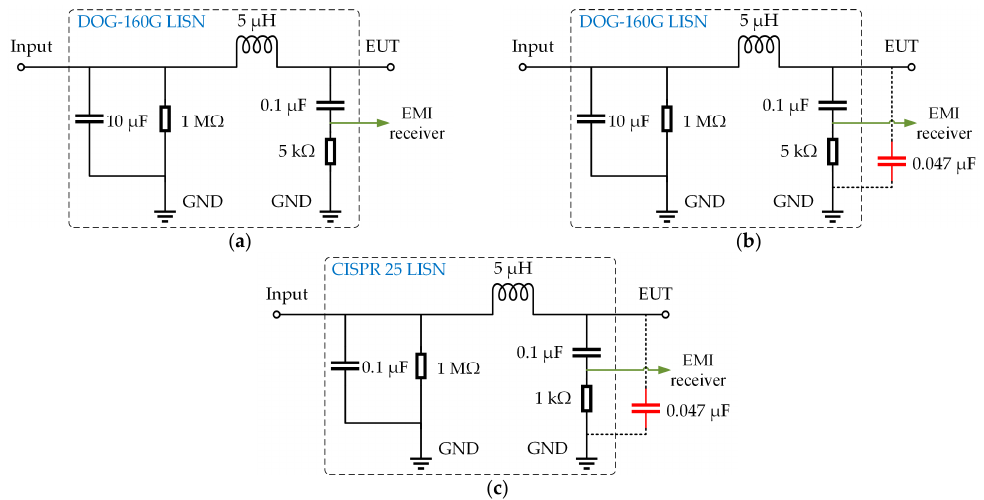
Figure 8. ( a ) DOG-160G LISN (LISN A), ( b ) LISN B1, and ( c ) LISN B2 used for model extraction ( a ) and verification ( b , c ). Only one line (P or N with ground) is shown.